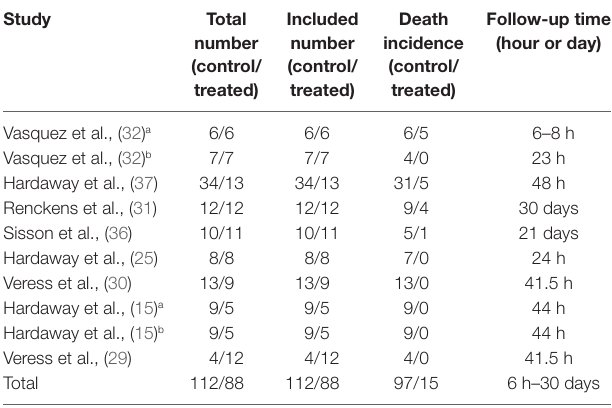
taBLe 3 | Data quality included for analyzing mortality.